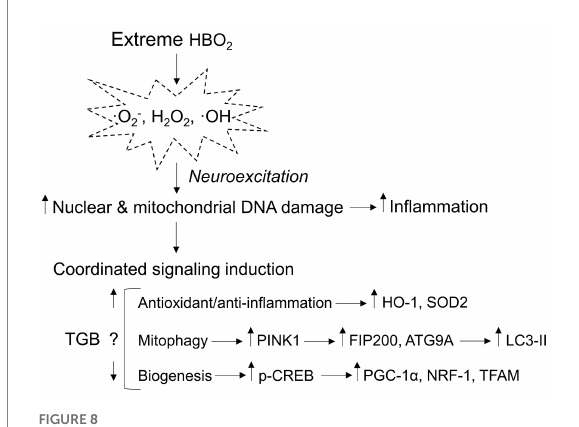
FIGURE 8 Mitochondria-related signaling responses to extreme HBO 2